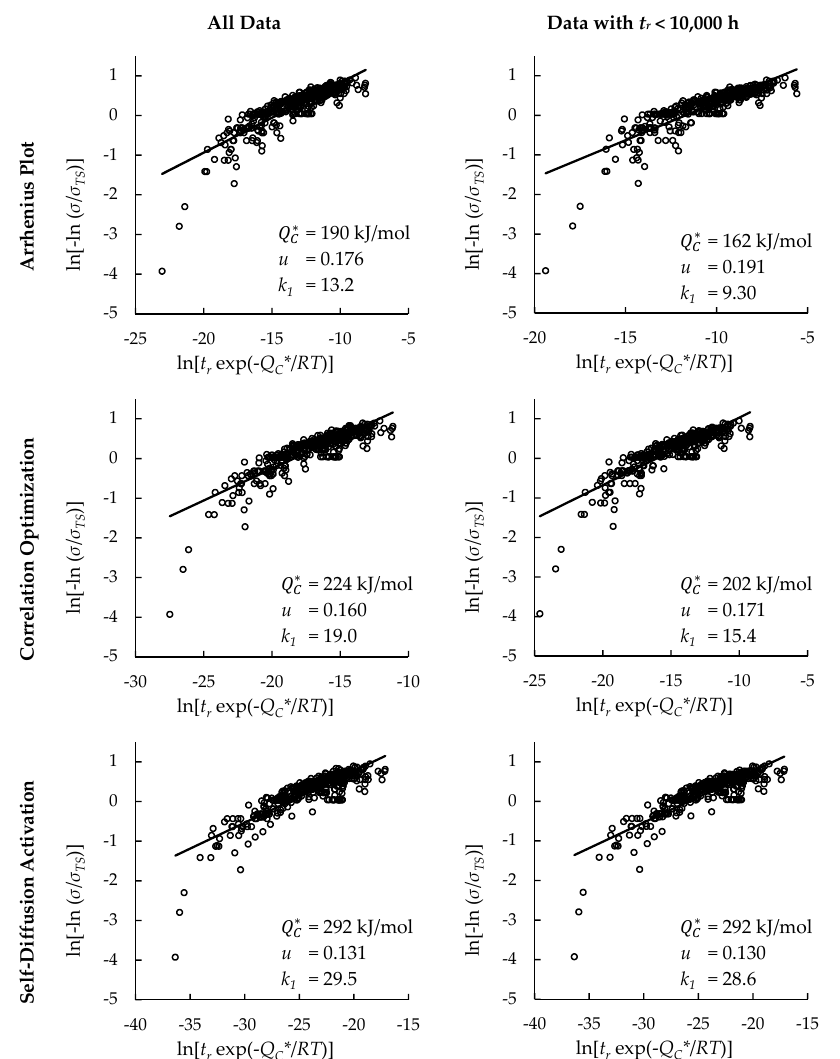
Figure A1. Wilshire plots of Inconel 617 creep rupture data treated as a single region.